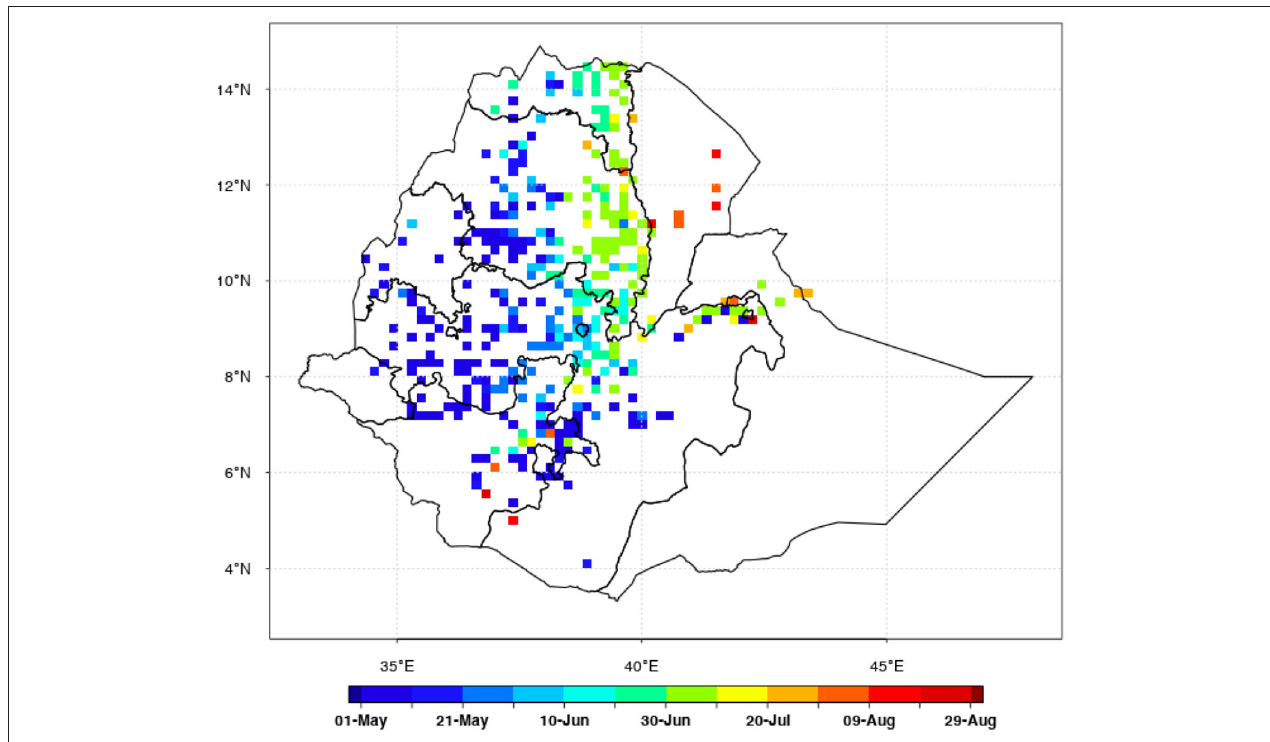
FIGURE 15 | Example of map output for onsets dates over Ethiopia. Onset seems to start in May for the southwestern part of the country (blue color), and in August for the northeastern part of the country (red